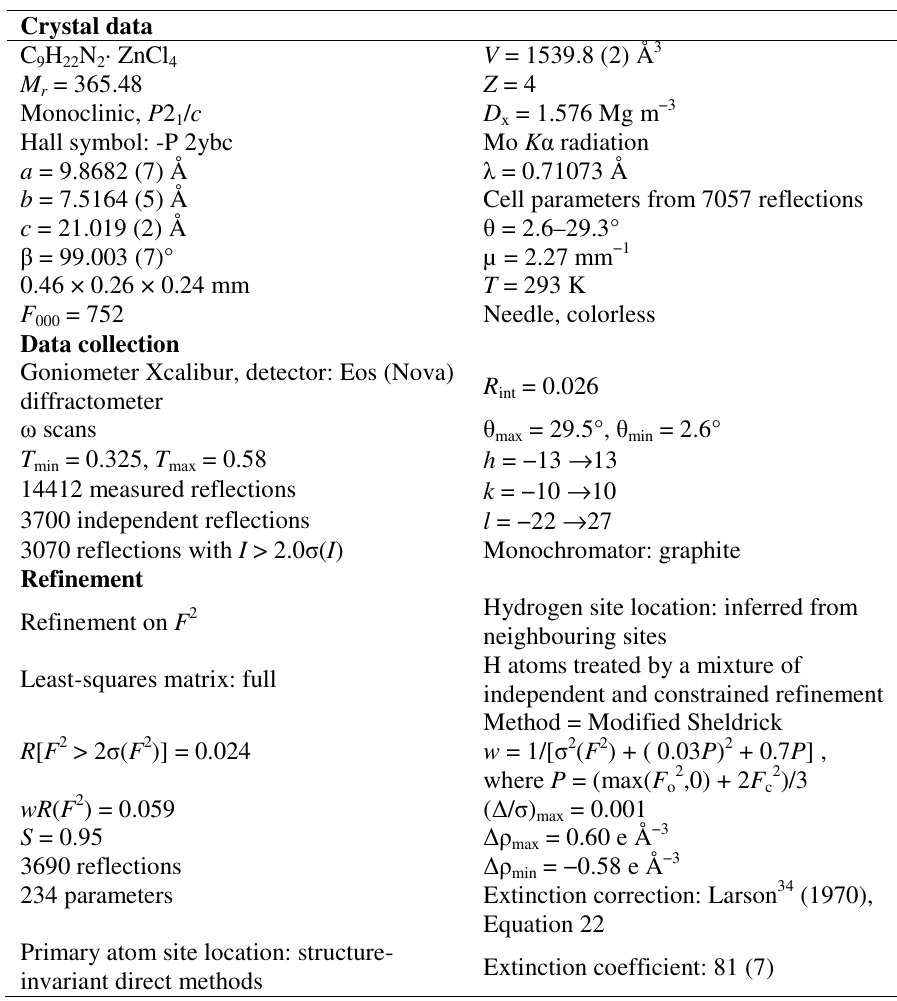
H N ]ZnCl 9 22 2 4